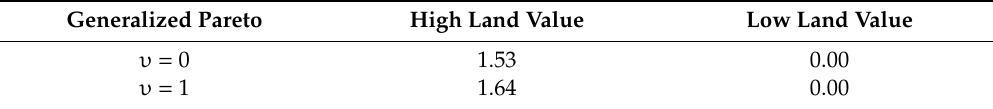
Table 7. Optimal safety factor for levee heightening for Technosociety.